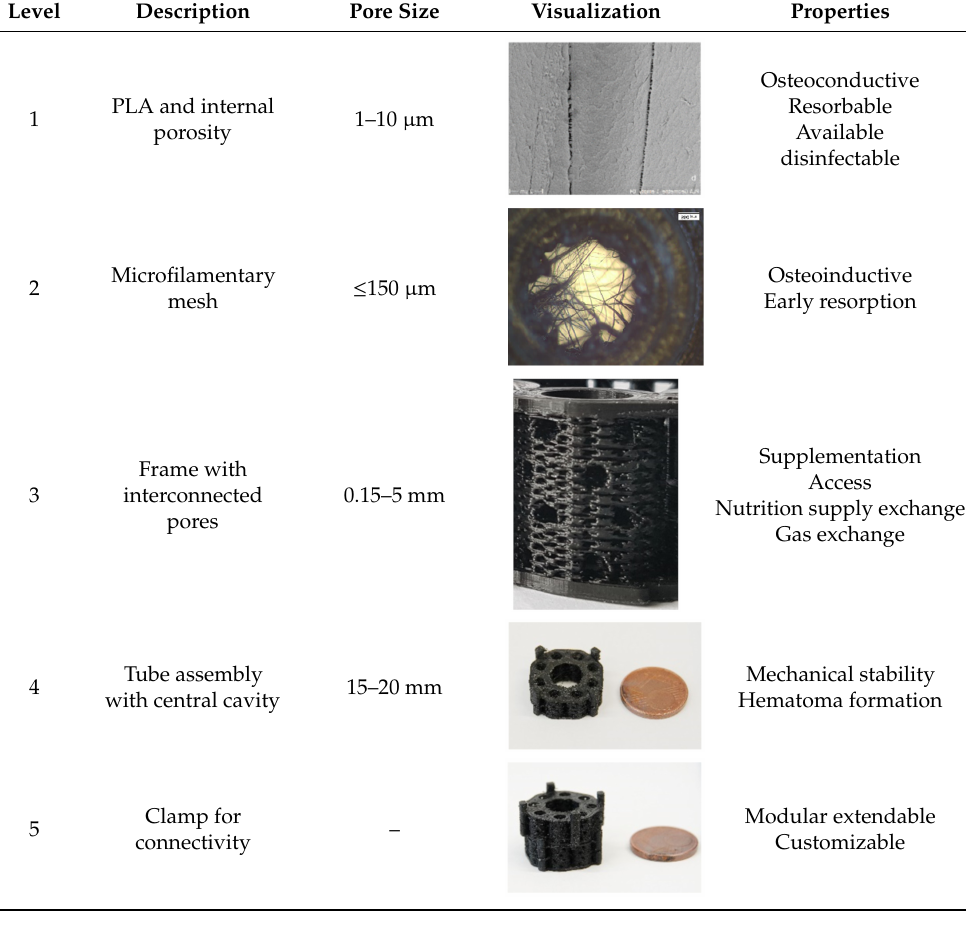
Table 1. Design concept of hierarchically organized levels for modular scaffold assemblies (explanation in text). For better illustration of structure details, dyed PLA was used here.